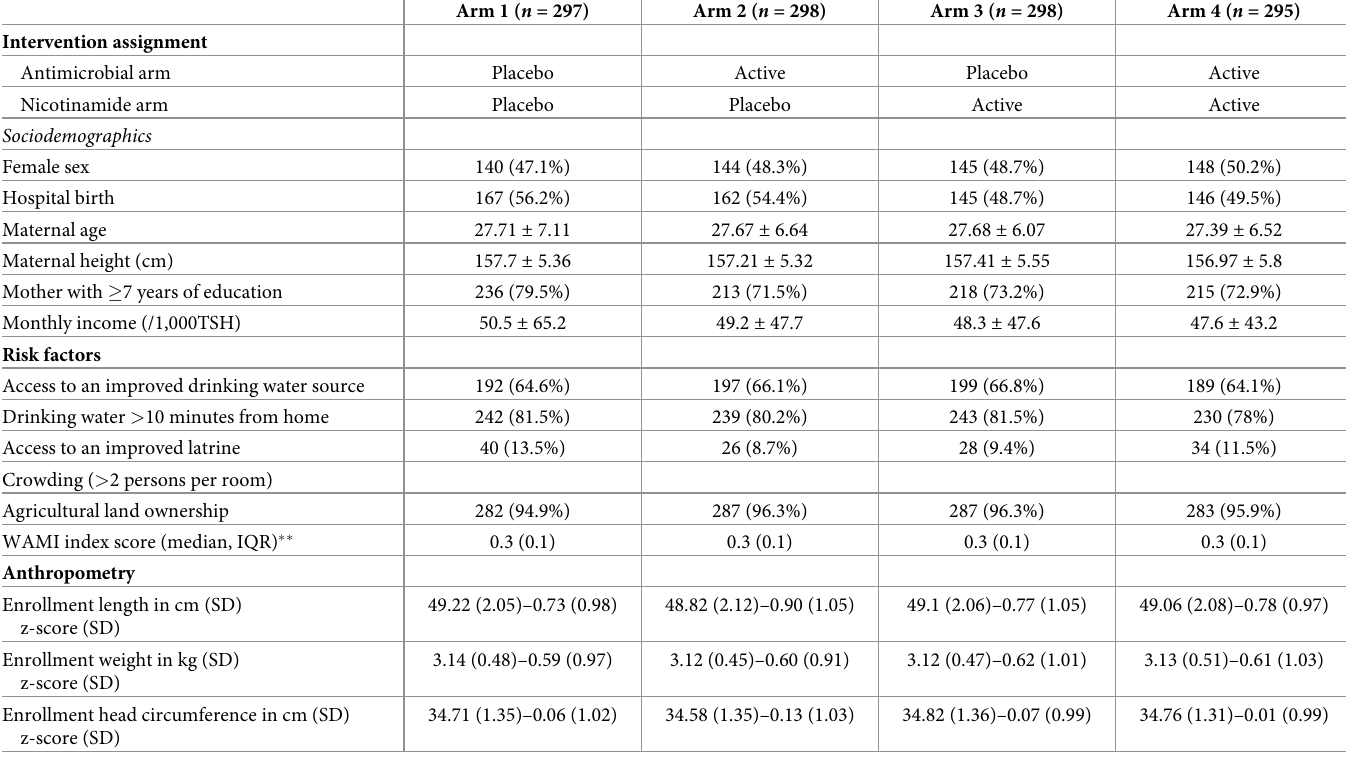
Table 1. Baseline characteristics of the full recruited cohort by intervention arm �